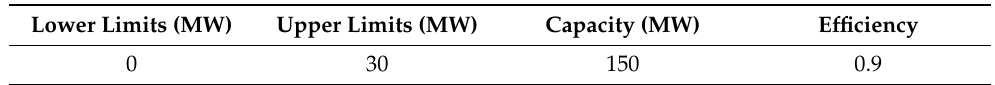
Table 2. Parameters of ESS.